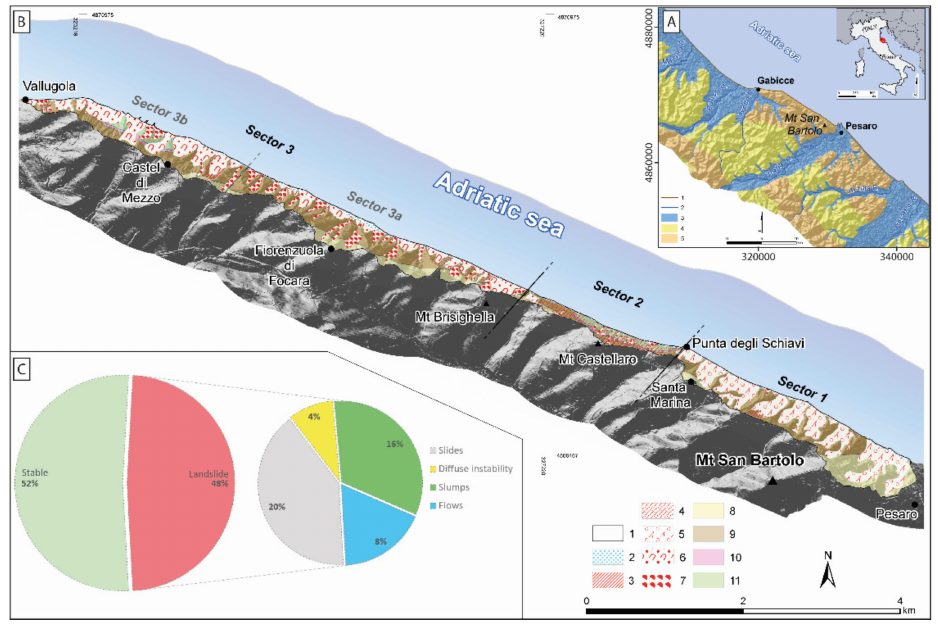
Figure 1. Setting of the Mt. San Bartolo coastal area. ( A ) Geological sketch of the northern Marche coastal area and inland surroundings (modified from [22]): 1, Coastline; 2, River; 3, Pleistocene– Holocene fluvial and coastal deposit; 4, Plio-Pleistocene pelitic and arenitic marine deposit; 5, Miocene marly calcareous, evaporitic, and terrigenous unit. ( B ) Geological and geomorphological sketch of the study area: 1, Study area; 2, Beach; 3, Landslide scarp; 4, Diffuse instability area; 5, Slide; 6, Slump; 7, Flow; 8, Colombacci Formation (Late Messinian); 9, San Donato Formation (Middle– Upper Messinian); 10, Gessoso Solfifera Formation (Lower Messinian); 11, Schlier Formation (Upper Tortonian). ( C ) Pie charts showing the percentage distribution of landslides and stable zones in the Mt. San Bartolo study area (on the left) and the percentage distribution of different landslide typologies occurring (on the right). (Map coordinates are in the WGS84–UTM 33 cartographic reference